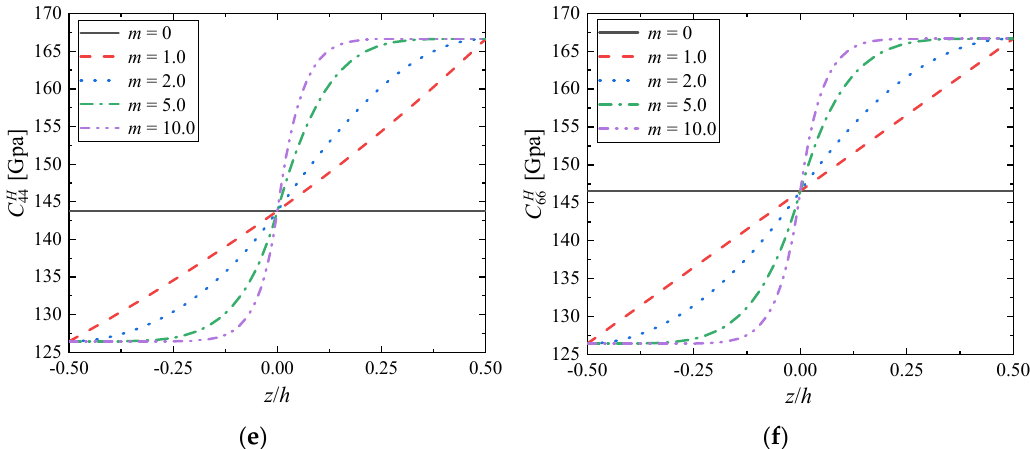
Figure 7. Distributions of ( a ) C 11 H ; ( b ) C 12 H ; ( c ) C 13 H ; ( d ) C 33 H ; ( e ) C 44 H ; ( f ) C 66 H along the gradient direction when c 0 = 1.0.